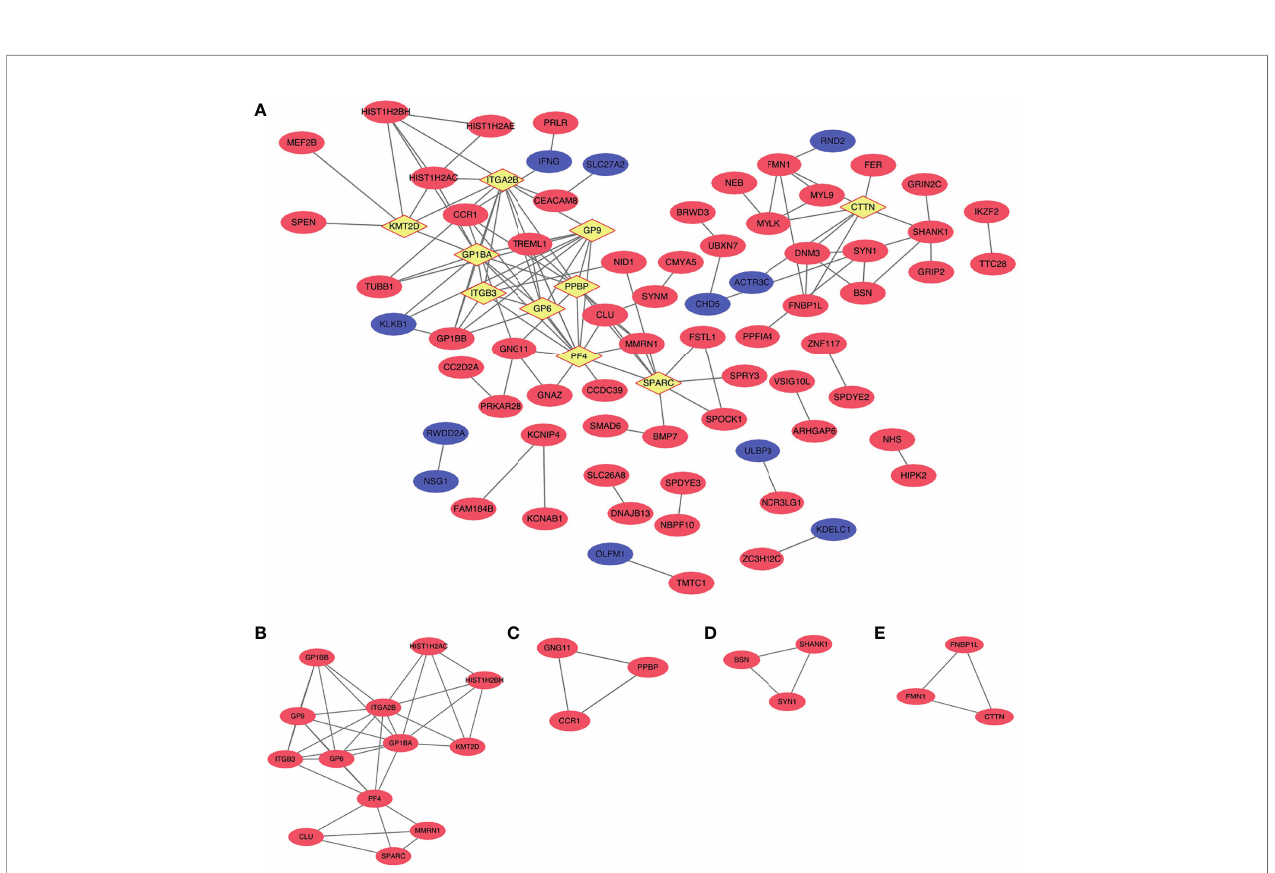
FIGURE 5 | Protein – protein interaction (PPI) network and the key modules of top 236 differentially expressed genes (DEGs) (|log 2 (fold change) >1.5|). (A) Cytoscape network visualization of the 182 nodes and 123 edges that were obtained with interaction scores >0.4 according to the STRING online database. The nodes denote proteins, and the edges correspond to the interactions between two proteins. Red, blue, and yellow colors represent upregulated, downregulated, and hub genes, respectively (B – E) Four key modules were identi fi ed by